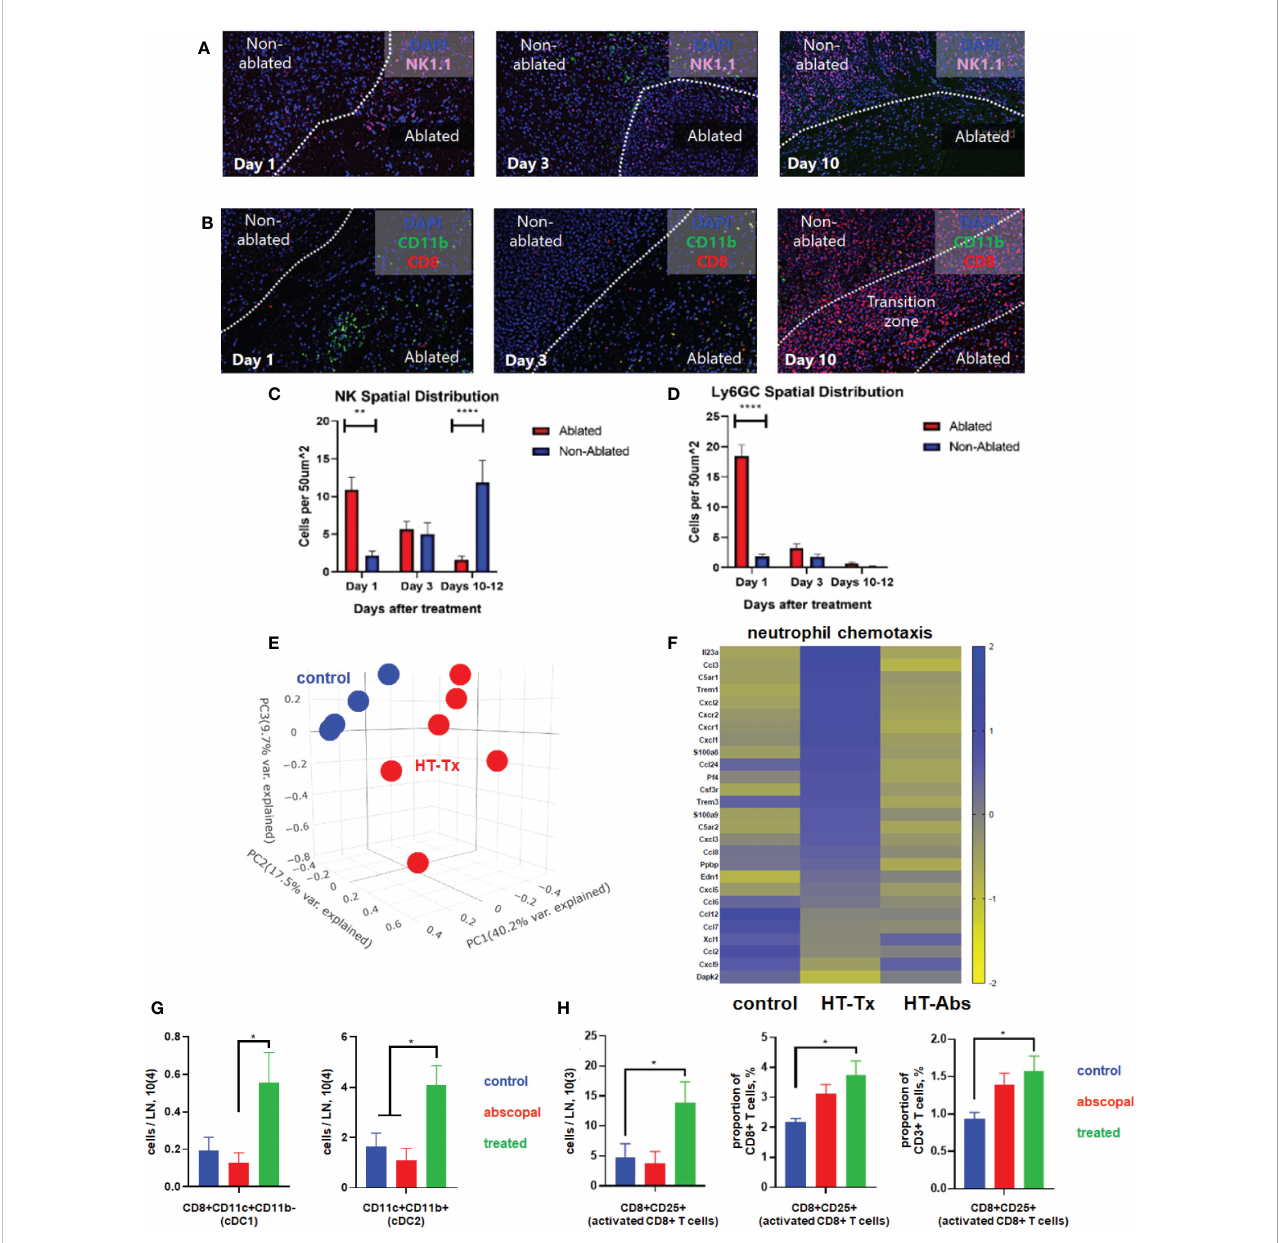
FIGURE 3 Histotripsy ablation is followed by in fi ltration of innate and adaptive immune cell populations. Mice bearing bilateral B16F10 tumors were treated with unilateral sham (control) or partial histotripsy ablation on day 10. Multicolor immuno fl uorescence performed 1, 3 and 10 days after sham or histotripsy partial histotripsy ablation revealed (A) early in fi ltration of NK1.1+ cells initially localized within the histotripsy ablated zone that gradually migrated outward toward peripheral, non-ablated zones on days 3 and 10, and (B) early and transient in fi ltration of CD11b+ cells within the histotripsy ablated zone on day 1 and delayed in fi ltration of CD8+ T cells within the non-ablated zone on day 10. (C) Quantitation of NK1.1+ cells within ablated zones (red) and non-ablated zones (blue) of histotripsy-treated tumors at various time points revealed gradual migration of NK cells away from ablated zones toward non-ablated zones. (D) Quantitation of Ly6GC+ cells at various time points after histotripsy con fi rmed immediate but short-lived in fi ltration strictly localized to the ablated zone. (E) RNASeq of CD45+ immune cells performed 3 days after unilateral partial histotripsy ablation revealed marked differences in transcriptional activity between control tumors (blue) and histotripsy-treated ( “ HT-Tx ” ) tumors (red) as evidenced by principal component analysis. (F) Upregulated transcription of genes associated with neutrophil chemotaxis was observed in histotripsy-treated but not histotripsy-abscopal ( “ HT-Abs ” ) tumors. (G) Mice bearing bilateral Hepa1-6 tumors were treated with unilateral partial histotripsy ablation on day 10. Flow cytometric analysis of tumor-draining lymph nodes of control (blue), histotripsy-treated (green) and histotripsy-abscopal (red) tumors performed on day 13 revealed signi fi cant increases in cDC1 and cDC2 populations within lymph nodes draining histotripsy-treated tumors. (H) Similarly, fl ow cytometric analysis revealed signi fi cant increases in activated CD8+ T cells within lymph nodes draining histotripsy-treated tumors. (n=3-6 mice per group; *=p<0.05 between groups; **=p < 0.01 between groups; ****=p < 0.0001 between